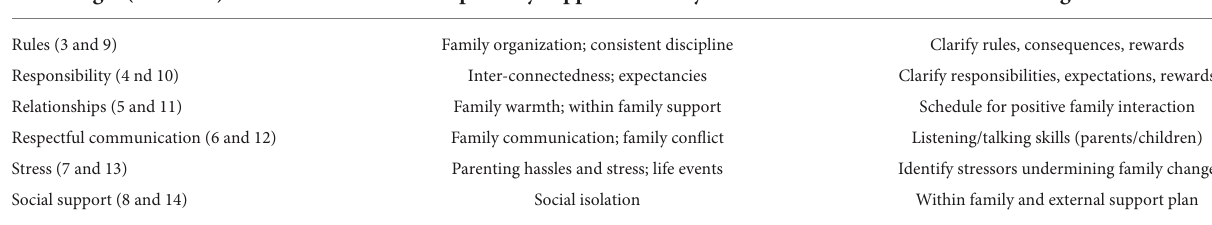
TABLE 1 MFG-based family strengthening